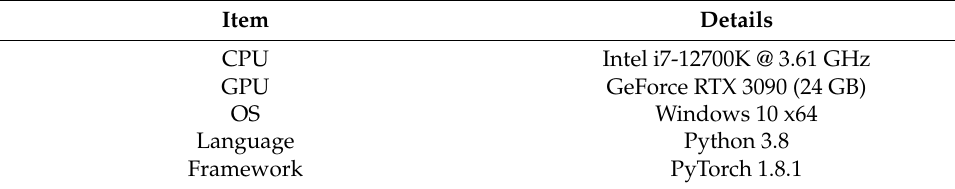
Table 3. Details of the employed hardware and